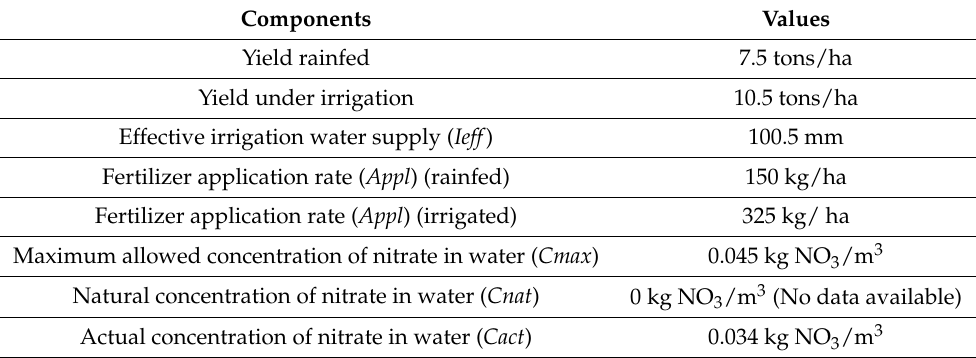
Table 1. Maize production data in the Napaleof ú